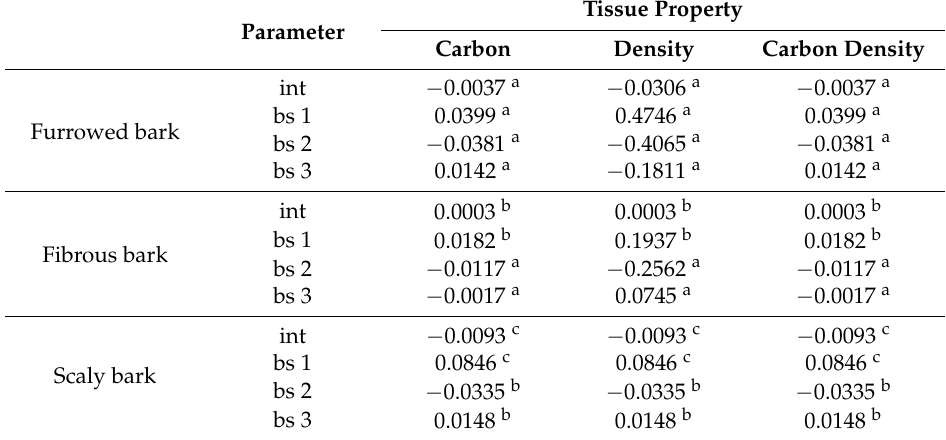
Table A1. Results for comparison of B-spline parameters fit to the three different tree groups for each tissue property. Comparisons are within tissue type only. Parameters with the same letter as a superscript for a given parameter are not significantly different from each other, while parameters between tree groups that have different letters are significantly different from each other. Int is the intercept of the spline fit; bs1, bs2, and bs3 are the parameter estimates for the first, second, and third knots, respectively. Parameter estimates within a tissue property are compared across bark groups with different superscript letters (a, b, or c) representing significant differences between bark groups for a given parameter (int compared to int, or bs 1 compared to bs1). Where superscripts are the same the differences were not